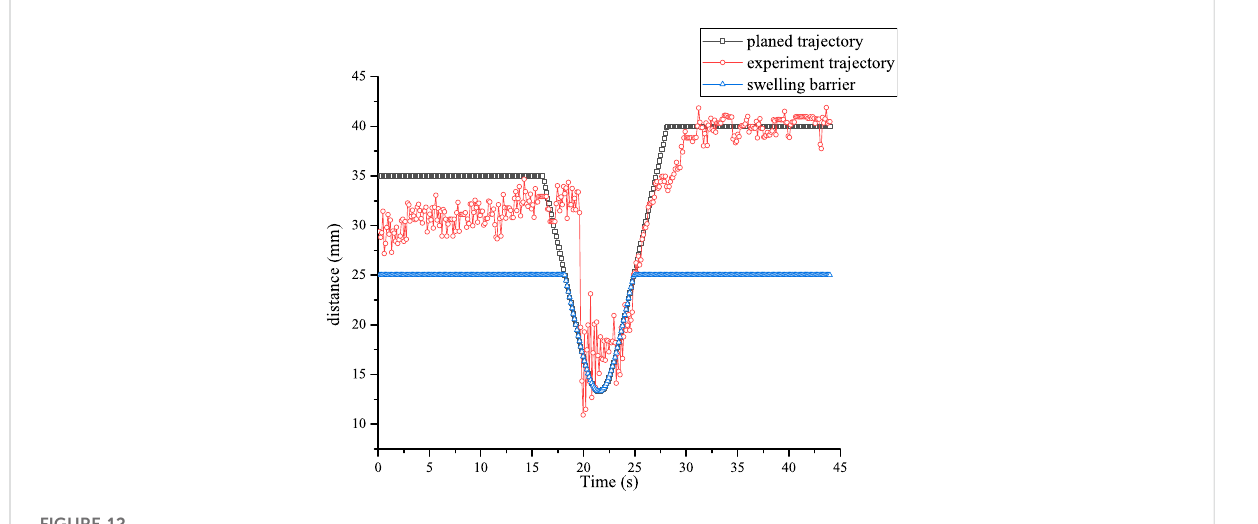
FIGURE 12 Change curve of the distance between the SRA ’ s end and the obstacle